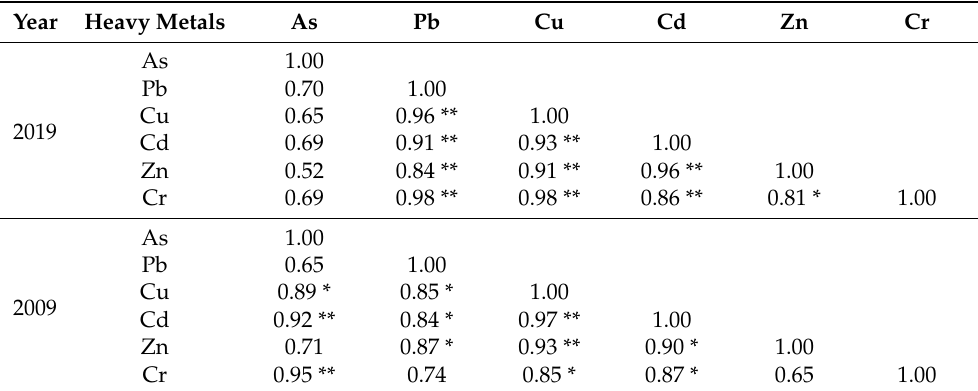
Table 6. Pearson’s correlation matrix for the heavy metal concentrations in the surface sediments of the Huaxi Reservoir in 2019 and